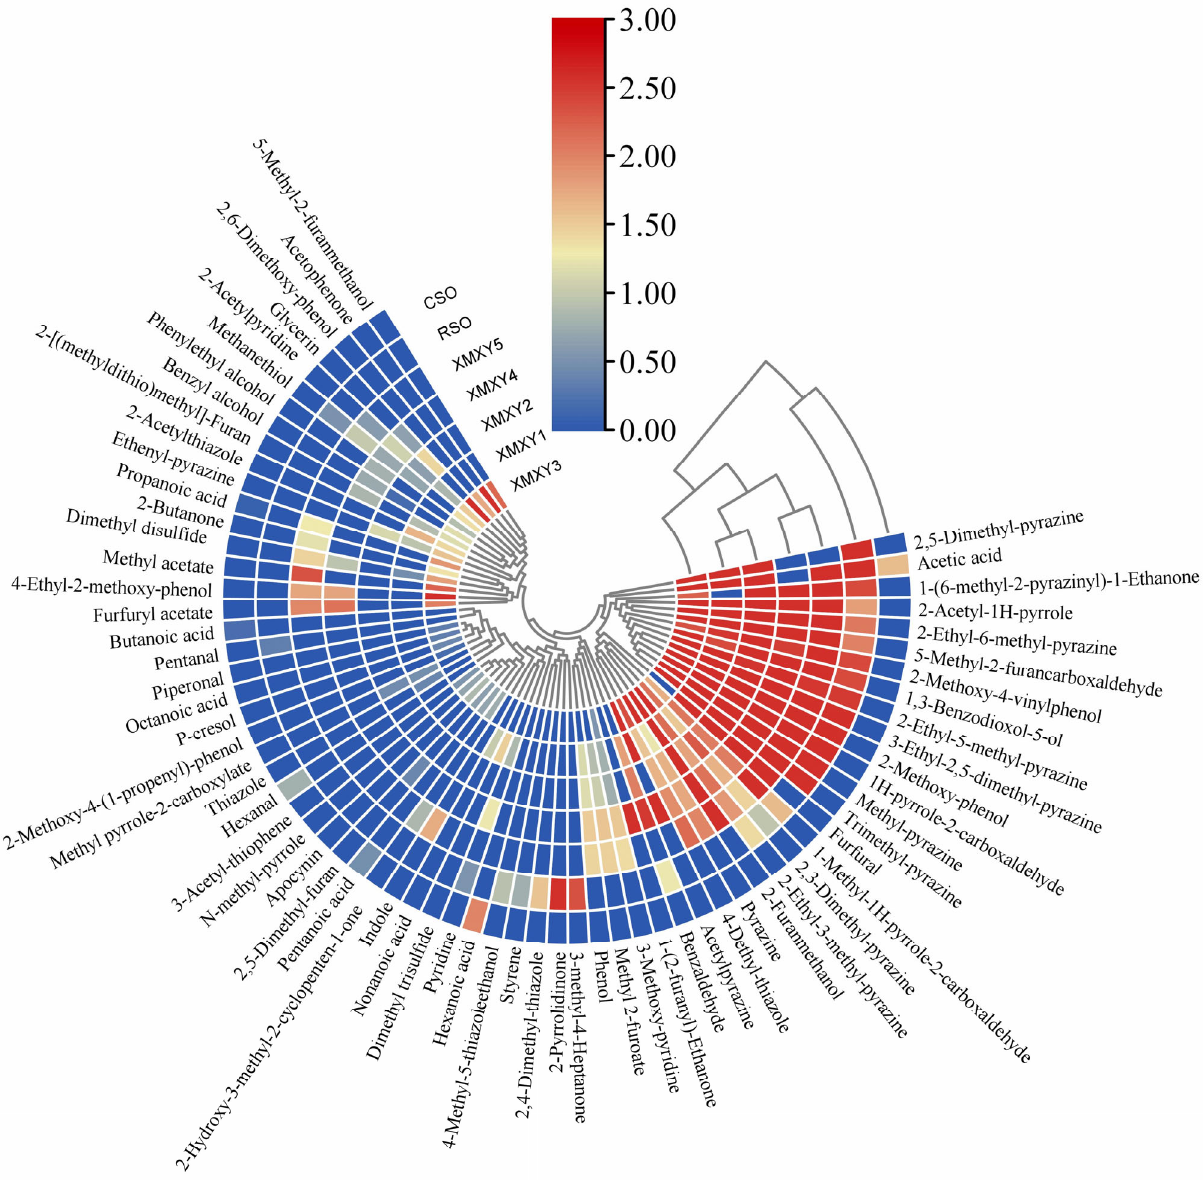
Figure 1. A heat map of volatile compounds in XMXY1–5, RSO, and CSO samples. XMXY1–5: Xiao Mo Xiang You 1–5; RSO: roasted sesame oil; CSO: cold-pressed sesame oil. Eight phenols were identified in the volatile compounds of the XMXY samples. 2-Methoxy-phenol (14.84–85.49 µ g/g) and 2-Methoxy-4-vinylphenol (4.08–23.78 µ